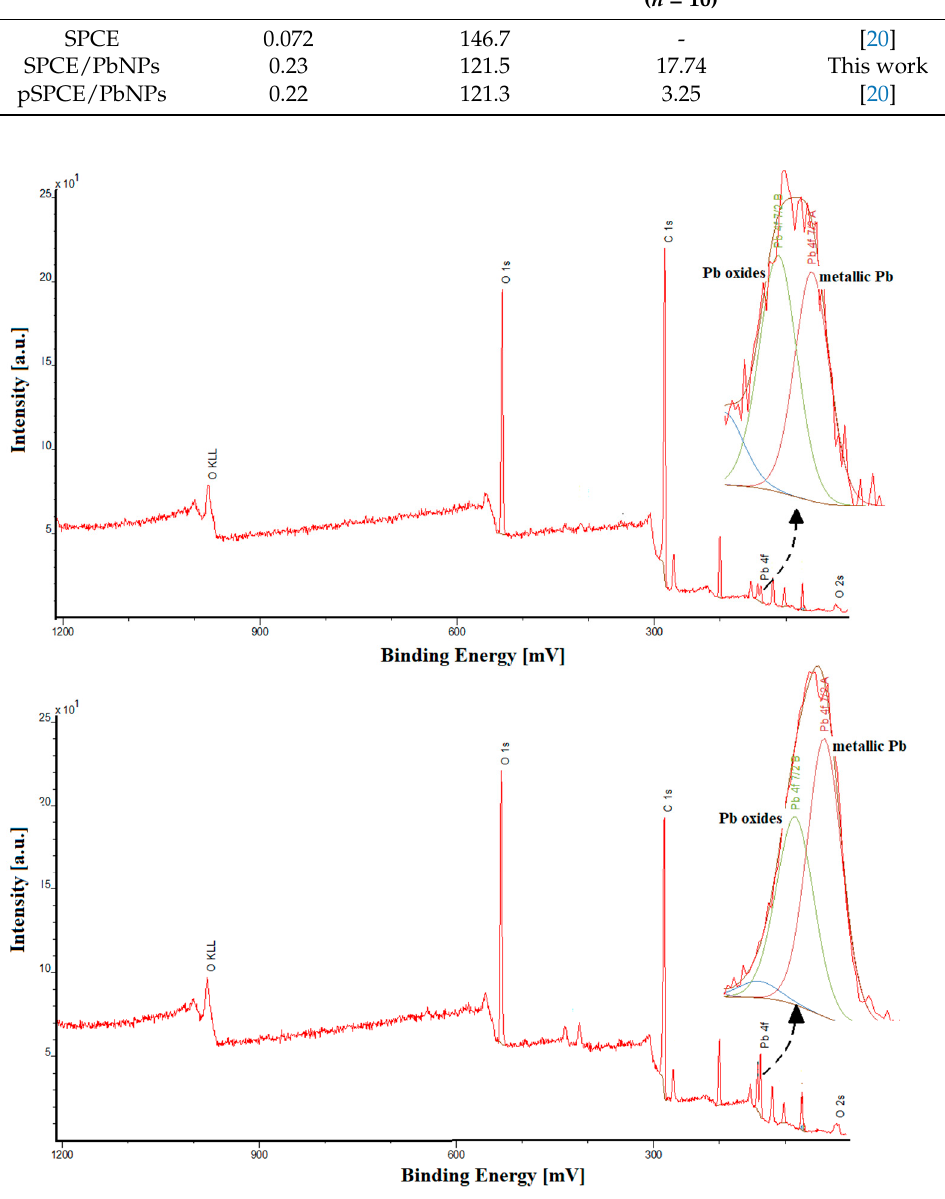
Figure 2. The XPS spectrum of the SPCE/PbNPs and pSPCE/PbNPs, and the deconvoluted Pb4f region.